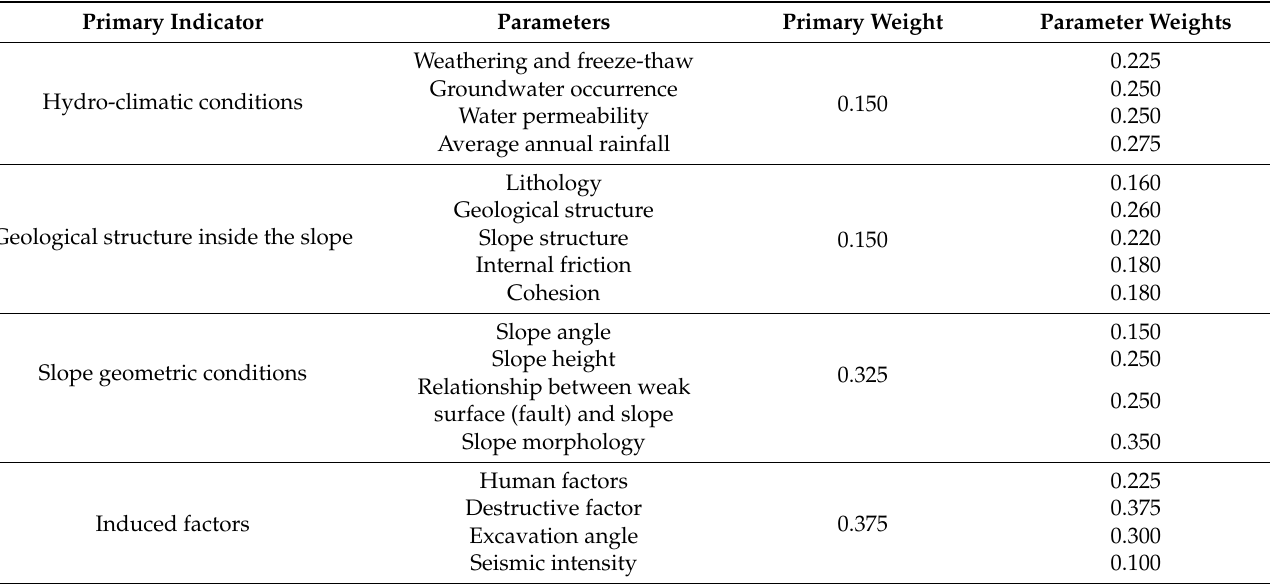
Table 4. Weights of risk parameters for the risk evaluation